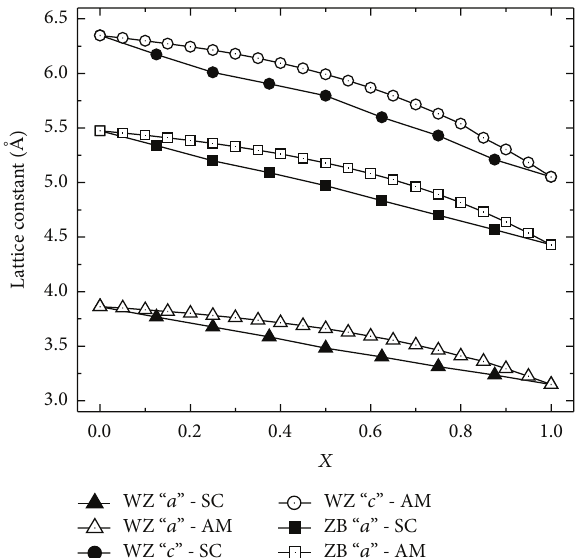
Figure 1: Composition dependence of lattice constants in both structures, zinc-blende (ZB) and wurtzite (WZ). Filled points represent the supercell (SC) alloy simulation and empty points rep- resent the alchemical mixing (AM), while point shapes distinguish different